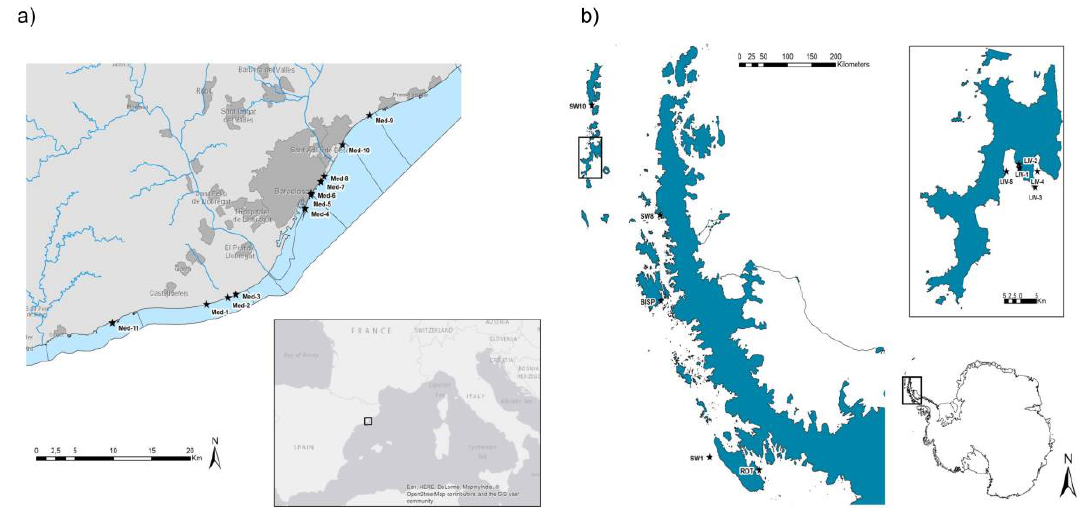
Figure 1. Seawater sampling sites. ( a ) Barcelona coast (Mediterranean Sea). ( b ) Livingston Island (Antarctica). Stars represent the sampling sites in each area.